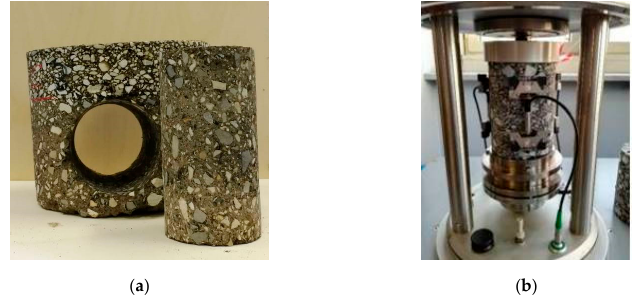
Figure 8. ( a ) Horizontal coring from core of 200-mm diameter; ( b ) detail of the specimen mounted in the asphalt mixtures performance tester (AMPT Pro).